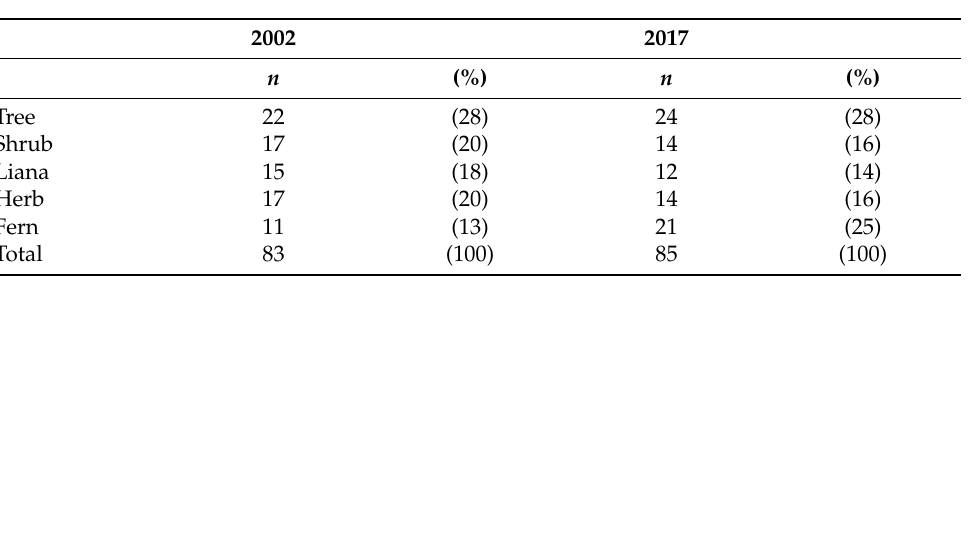
Table 1. Number of plant species of understory vegetation in 2002 and 2017